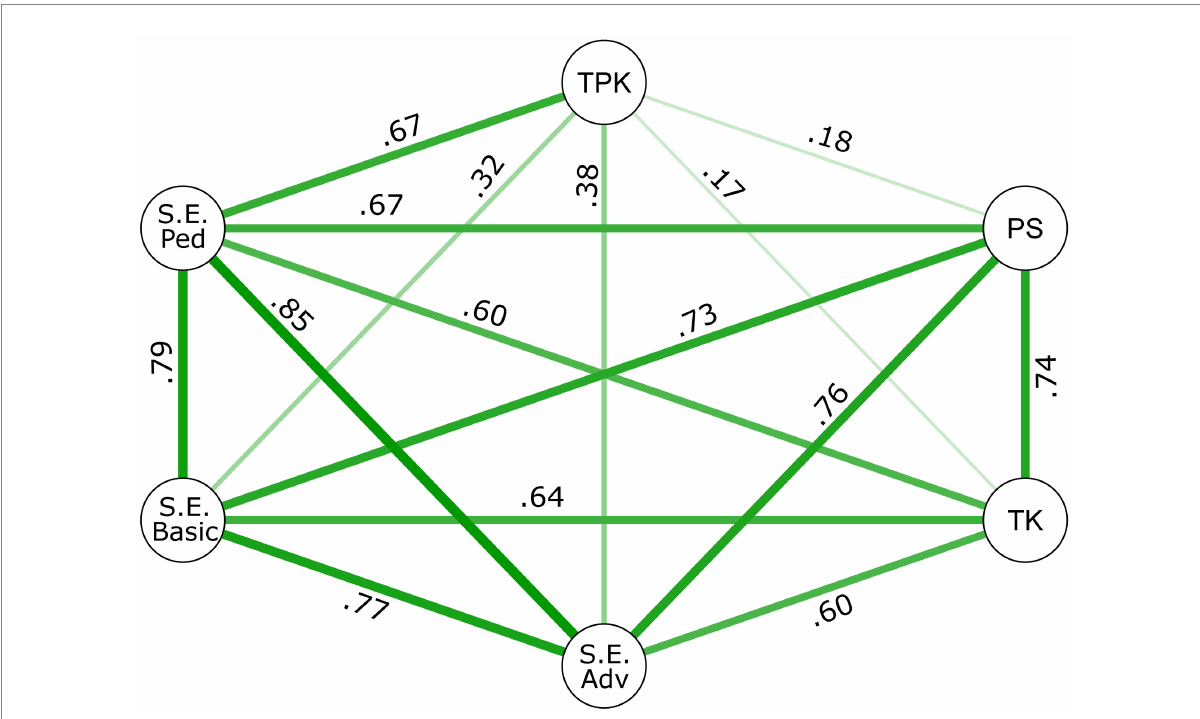
FIGURE 2 Associations between the latent variables. The widths of the lines indicate the strength of the correlations. All correlations are significant ( p < 0.05, N =